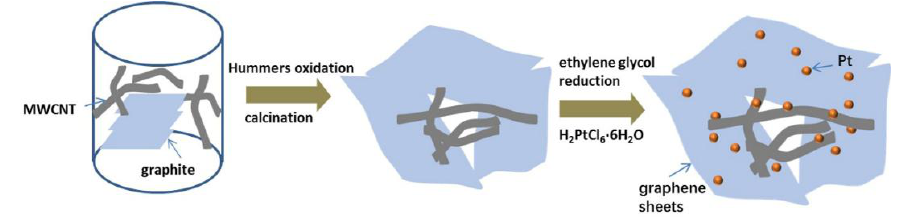
Figure 1. The procedures showing the preparation of Pt/G-M.